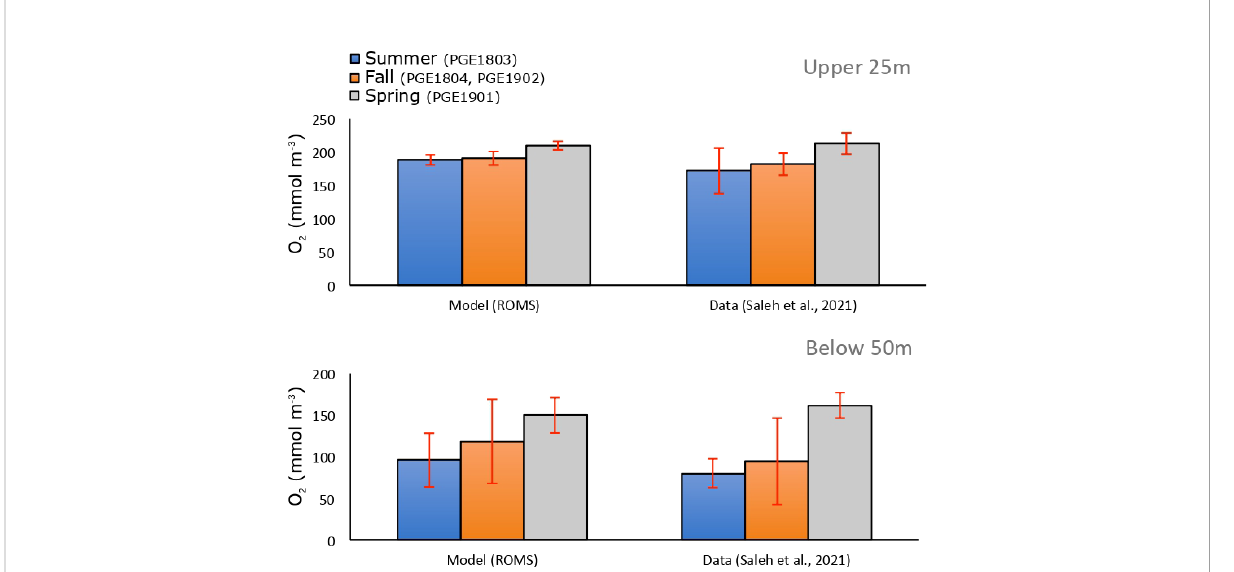
FIGURE 2 Evaluation of the model simulated dissolved O 2 concentrations. O 2 concentrations in the the Gulf (Iran EEZ) in late summer (blue), late autumn (orange) and spring (gray) as simulated by ROMS (left) and from observations collected during cruises PGE1803, PGE1804, PGE1901, and PGE1902 in 2018 and 2019 by Saleh et al. (2021) (right) in the upper 25m (top) and below 50m (bottom). Bar plots correspond to average concentrations for each season while error bars show standard deviations around the mean. For this comparison, the model was sampled at the observation points for each